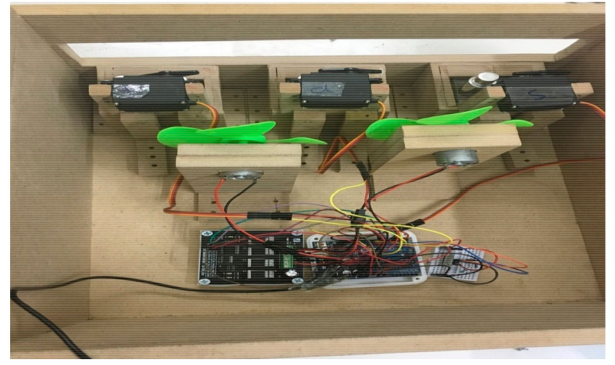
Figure 2. Overview of the device.